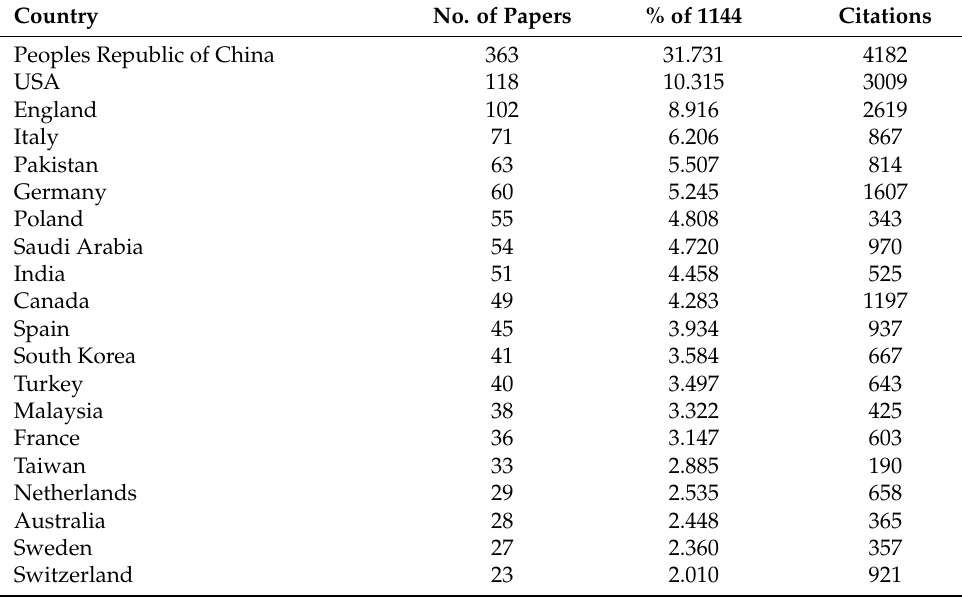
Table 3. Documents on green and renewable energy and innovation by